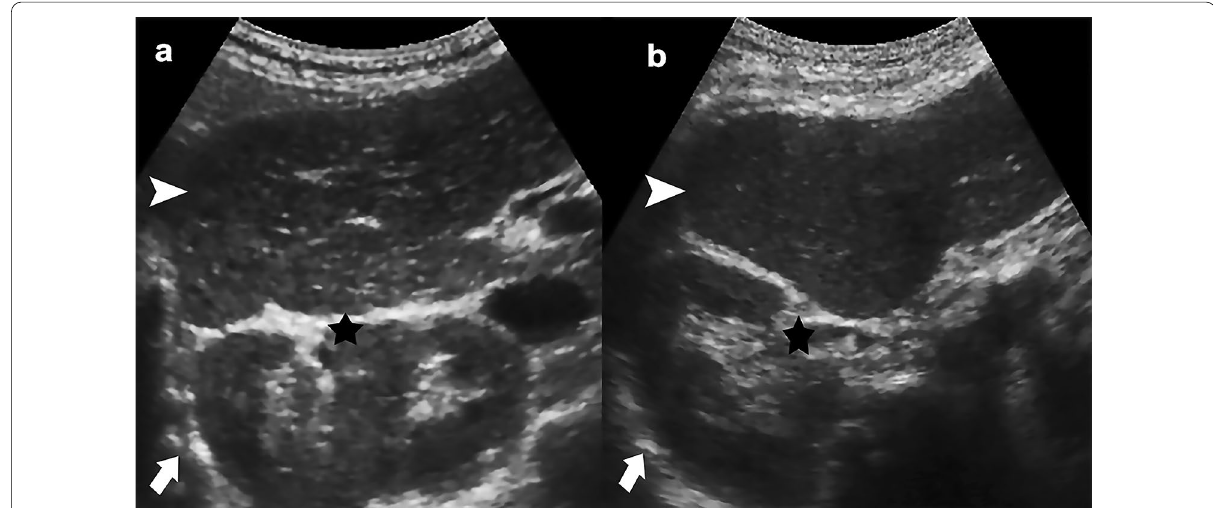
Fig. 1 a Sagittal ultrasound image showing the subdiaphragmatic position of the right kidney (thick arrow) posterior to the liver (arrowhead) with anteriorly located right renal hilum (star). b Sagittal ultrasound image showing the subdiaphragmatic location of the left kidney (thick arrow) posterior to the spleen (arrowhead) with normally located left renal hilum